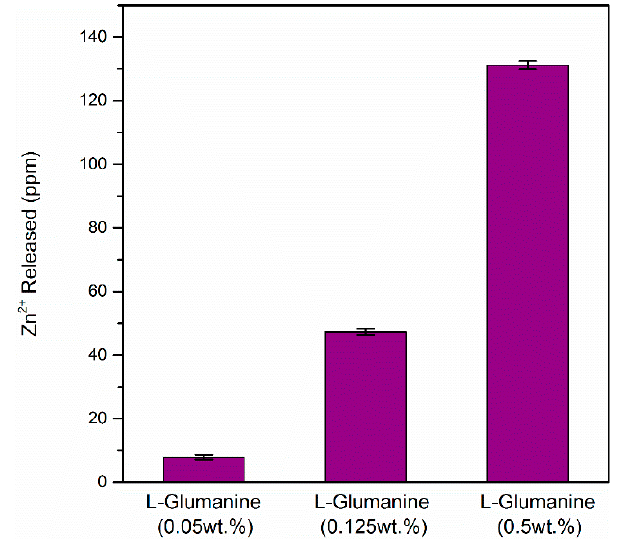
Figure 2. Zinc released from the ZnO35 pellet after 24 h in different concentrations of L -Glutamine.